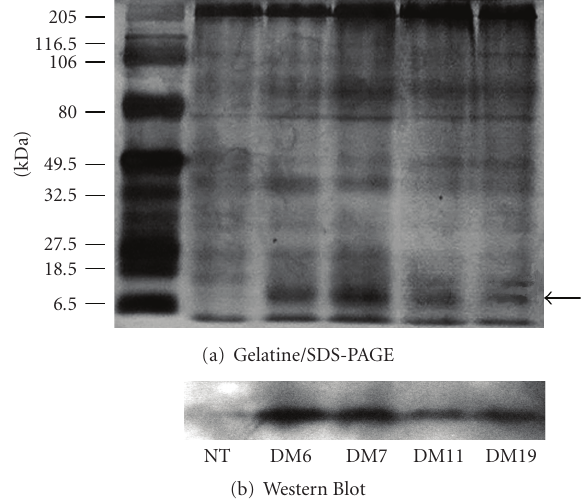
Figure 1: Detection of (a) Trypsin inhibitors by gelatin/SDS-PAGE contained in nontransformed (NT) and selected DM lines. Trypsin inhibition by PIs contained in plant extracts was visualized by stains. Arrow indicates MTI-2; (b) MTI-2 by ECL Western blotting in nontransformed (NT) and selected DM